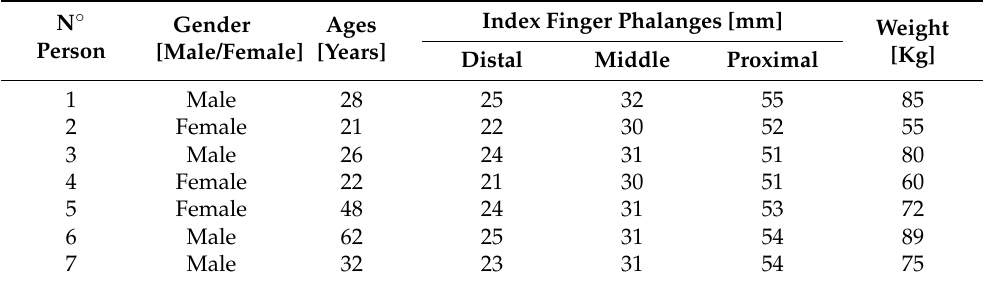
Table 2. The features of people’s